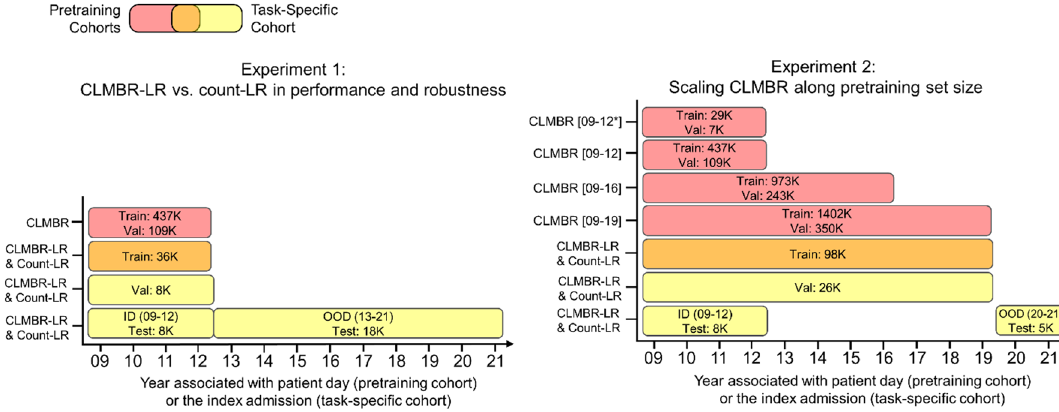
Figure 2. Year range for cohort selection and the dataset size for CLMBR pretraining and task-specific models. The Venn diagram (top left) illustrates the overlap between patients in the pretraining cohorts and the training set of the task-specific cohort. The asterisk in CLMBR [09–12*] indicates a subset of CLMBR [09–12] and only included patients who were admitted to an inpatient unit between 2009 and 2012. Flow diagrams of patient cohort allocation in supplementary Methods online detail the assignment of patients into each cohort and the data splitting procedure. Note that the datasets for the task-specific cohort may vary in the number of patients across clinical outcomes due to additional exclusion of patients for each outcome. For instance, for ICU admission predictions we excluded patients who were transferred on the first day of the index admission since these events would have occurred before prediction time. CLMBR Clinical language model-based representation; LR Logistic regression; ID In-distribution; OOD